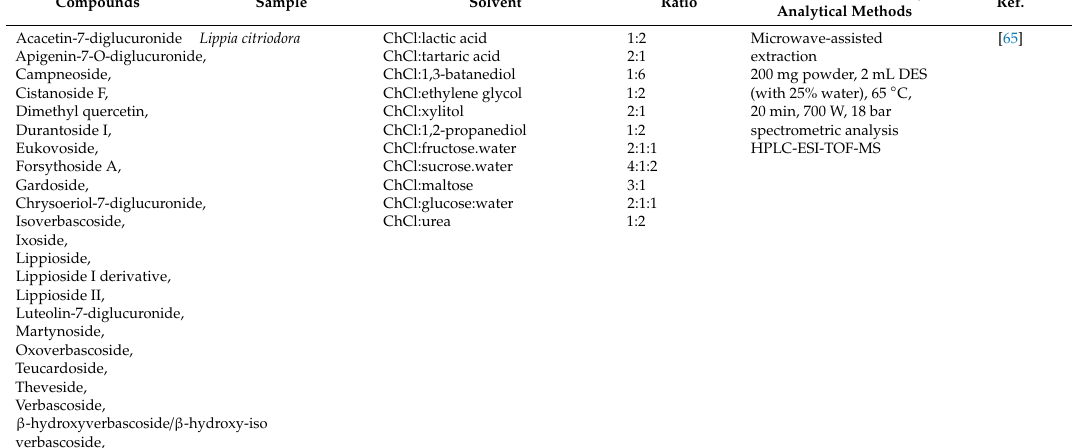
Table 1. Value-added compounds extracted from phytomass by Type III DESs and extraction conditions. Compounds Sample Solvent Ratio Extraction Conditions; Analytical Methods